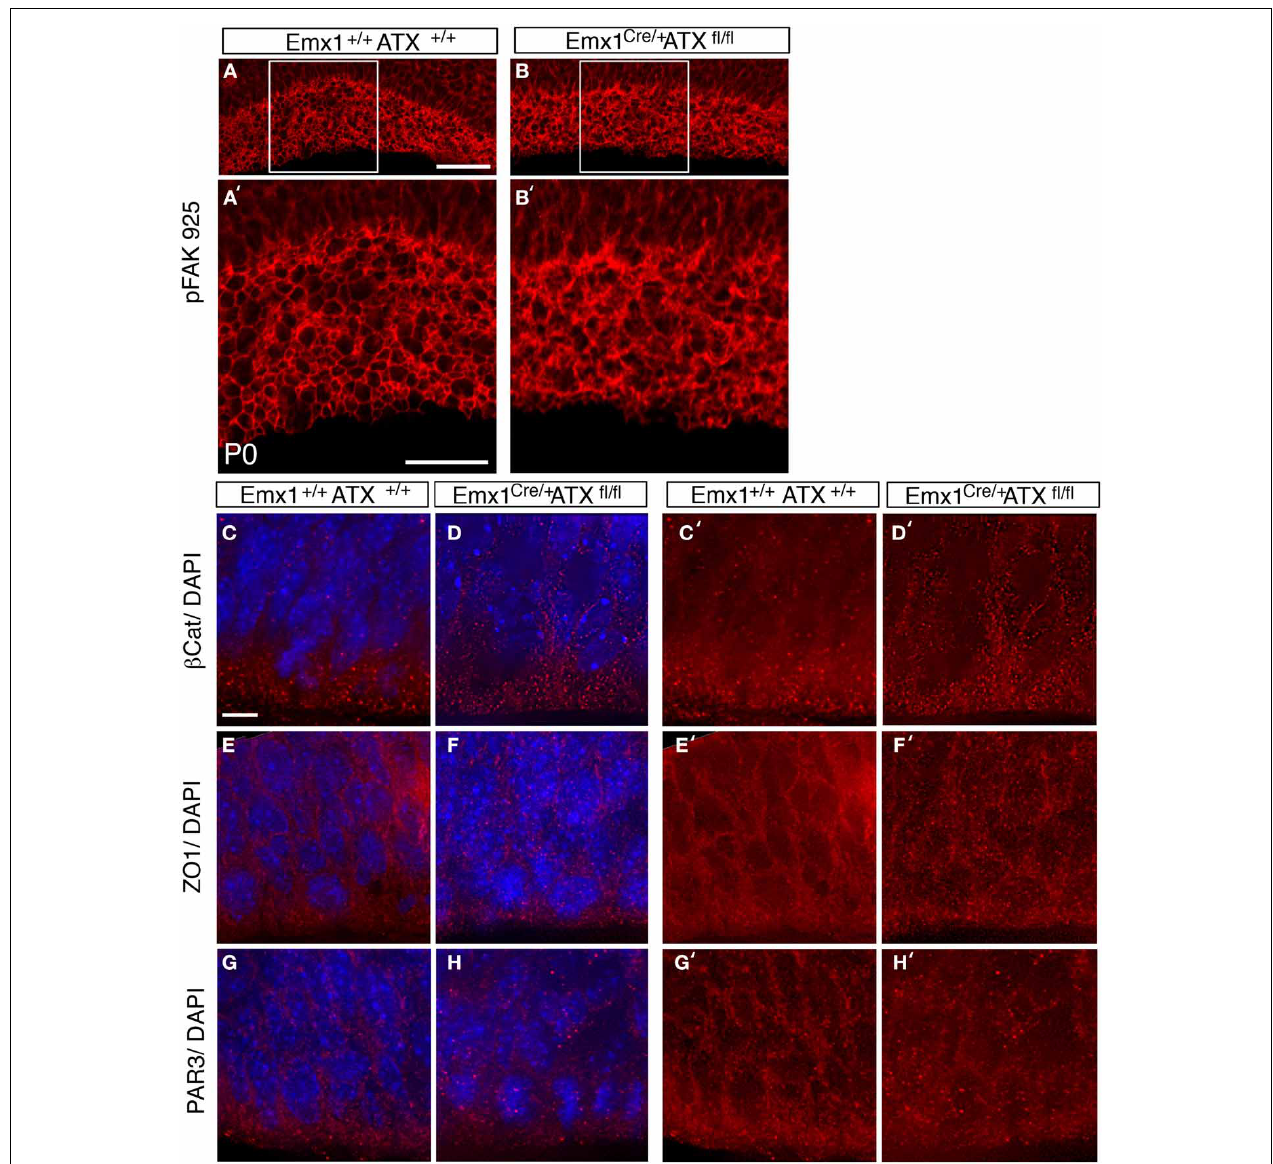
FIGURE 5 | ATX knockout have subtle effects on adherence junctions in the apical VZ. (A–B’) Disruption in pFAK 925 immunostaining is observed in ATX knockout mouse. (B,B’) when compared to floxed allele carrier, non-deleted littermate at P0 (A,A’) . (C–H’) Staining with adherence junction